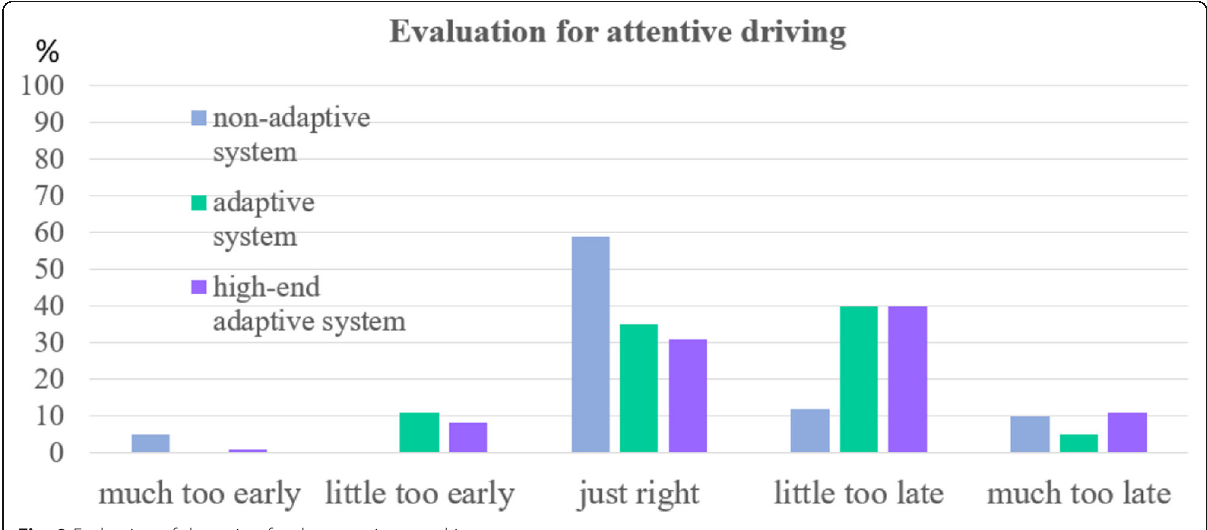
Fig. 9 Evaluation of the rating for the attentive test